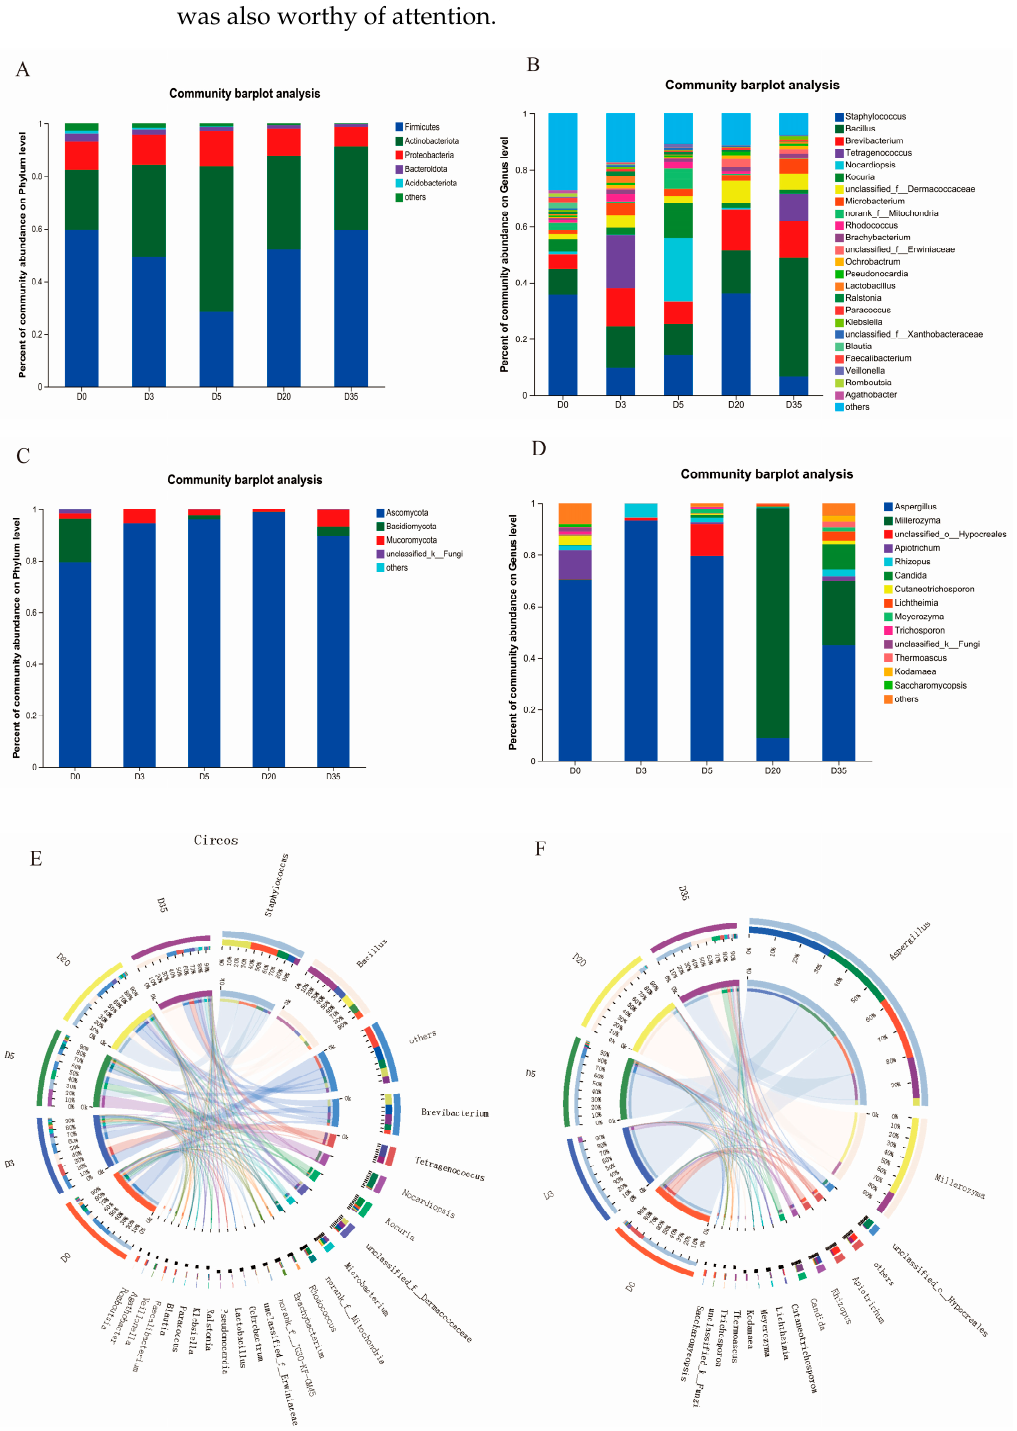
Figure 3. Characteristics of relative abundance of bacteria at the phylum ( A ) and genus ( B ) levels of Aspergillus -type Douchi from different fermentation periods. The relative abundance of fungi at the phylum ( C ) and genus ( D ) levels of Aspergillus -type Douchi during fermentation. Distribution of microbial community for each sample at the genus level. The data were visualized by Circos. The width of the bars from each genus indicates the relative abundance of that genus in the sample. ( E ): bacteria; ( F ): fungi.